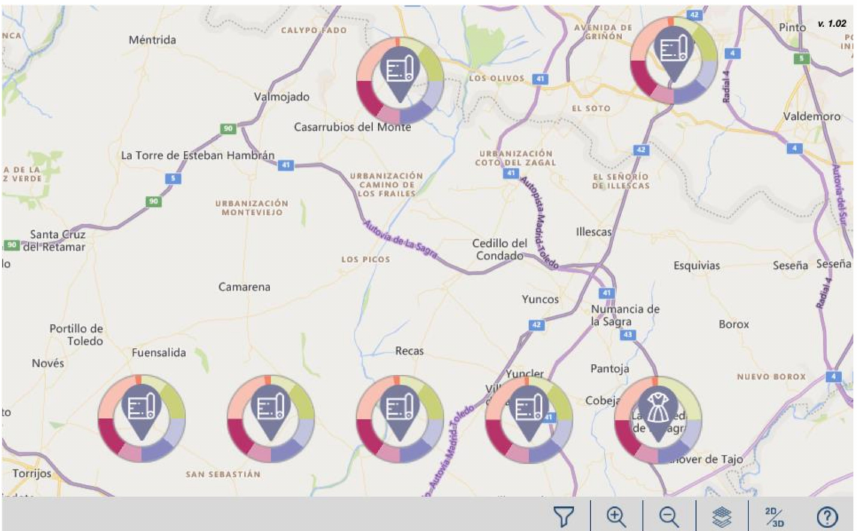
Figure 5. Ring-based representation of the relationship between the properties of the objects in SILKNOW. Here we can see four ring sections (orange, red, green and blue) for each object. Each colored ring section represents a property of the object and is divided in two parts (one lighter and one darker) showing the percentage of objects in the map that share each property with this